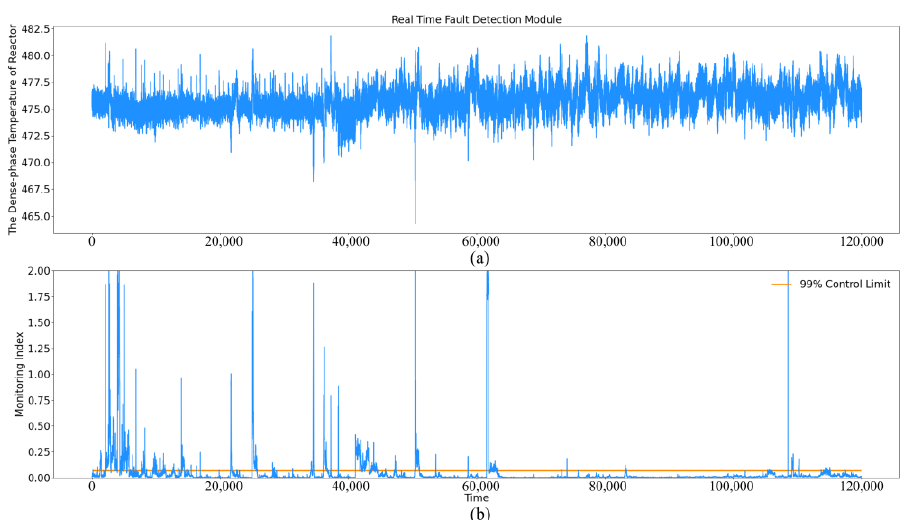
Figure 7. Three-month online process monitoring results (the model is trained with data labeled by the proposed method): ( a ) Original data of the key variable; ( b ) Fault detection results. Table 2. Calculation time of each model update.